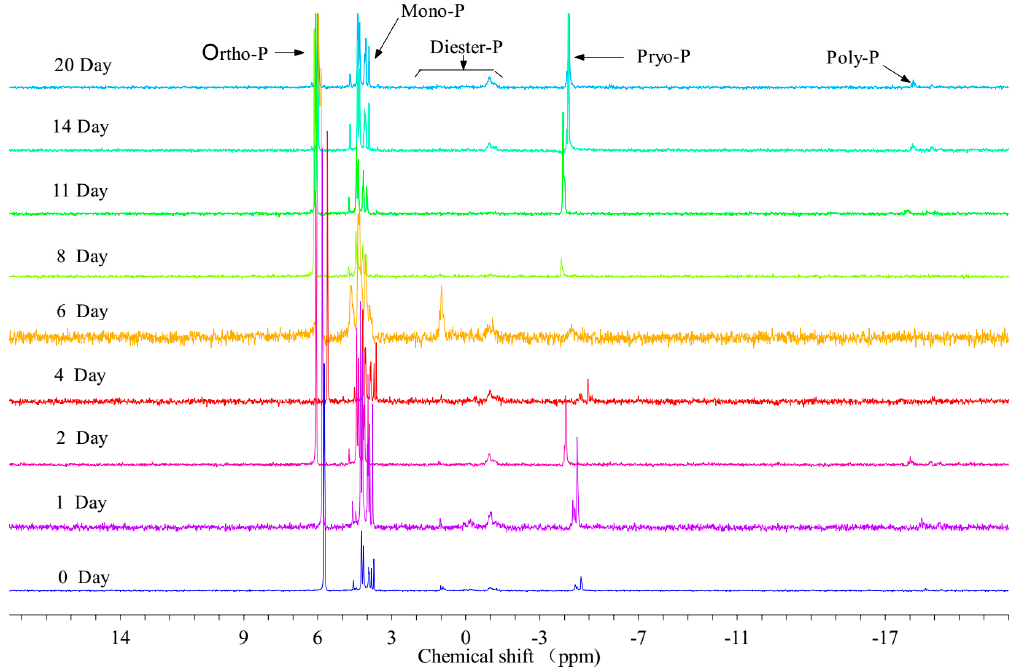
Table 2. Percentage of each P species in PPOM during PPOM degradation experiment.